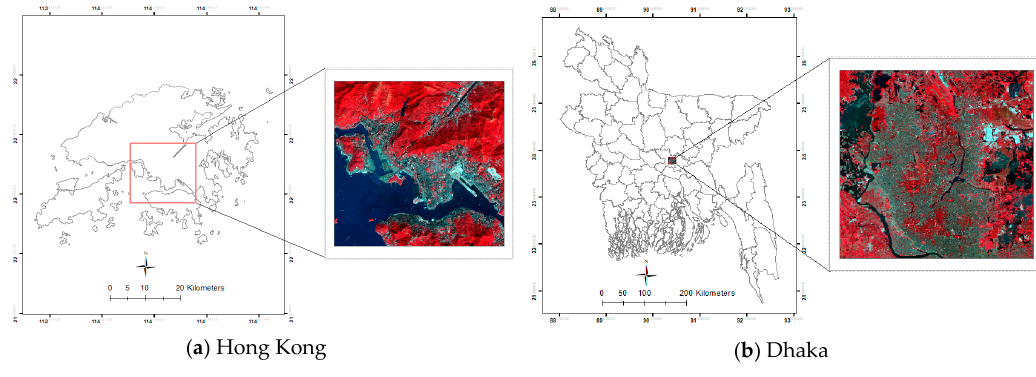
Figure 2. Location of the study sites.